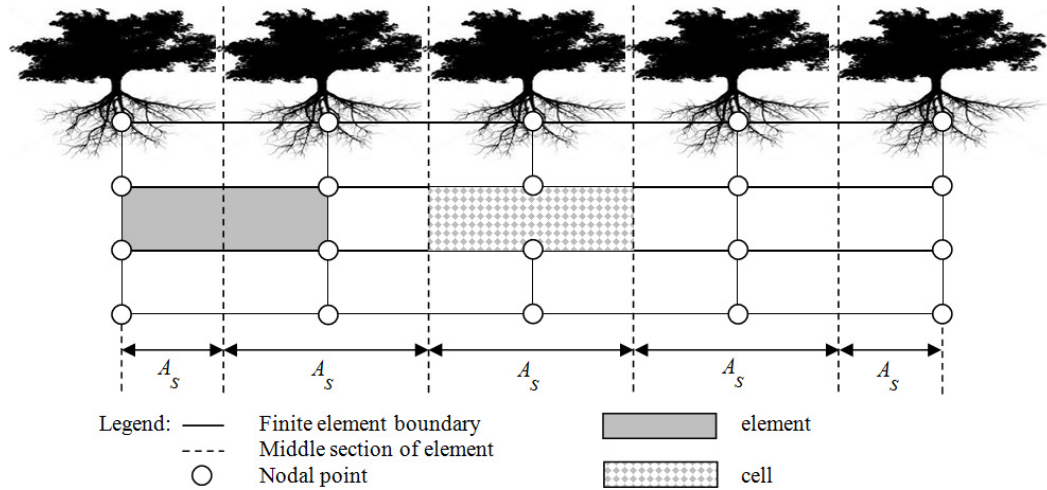
Figure 1. Schematic sketch of a hypothetical simulation case for illustration